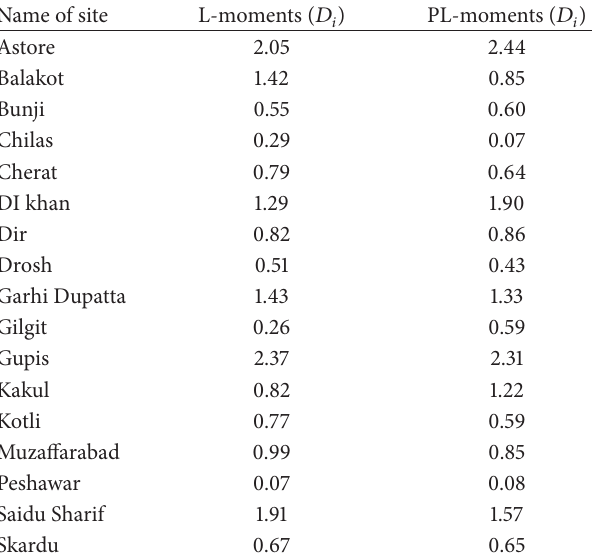
Table 3: Discordance test result based on L-moments and PL-